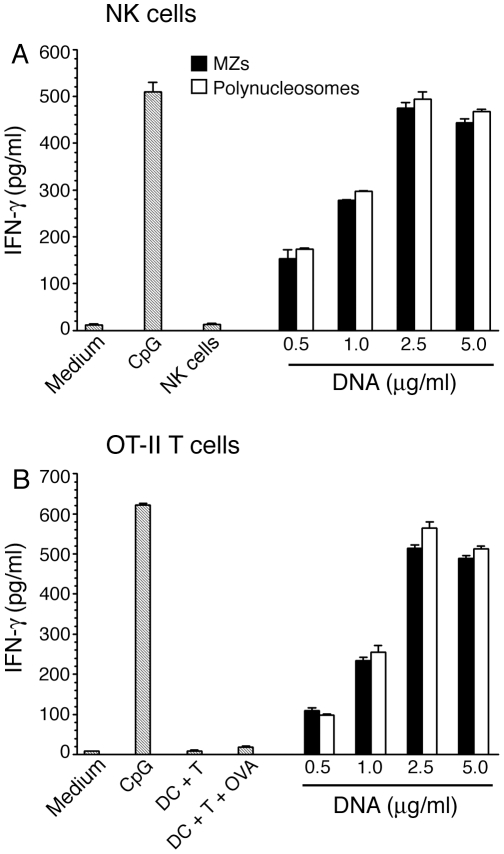

P. falciparum polynucleosomes-activated DCs stimulate NK cells and OT-II T cells to produce IFN-γ.
Panel A: WT FL-DCs were cocultured with NK cells and stimulated with the indicated doses of polynucleosomes (based on DNA content). After 36 h, the IFN-γ produced by NK cells was measured by ELISA. Merozoites (MZs) having the indicated DNA contents and CpG ODN were used as controls. Panel B: WT FL-DCs were stimulated with the indicated doses of polynucleosomes for 6 h and then cocultured with OT-II T cells in the presence of OVA323–339 peptide. After 72 h, the IFN-γ produced by T cells was measured by ELISA. In parallel NK cells, DCs or T cells were cultured individually or cocultures of DCs and T cells in presence or absence of OVA323–339 peptide, but not stimulated with polynucleosomes, were used as controls. Data are representative of two independent experiments, each performed in duplicates. Error bars represents mean values ± SEM.